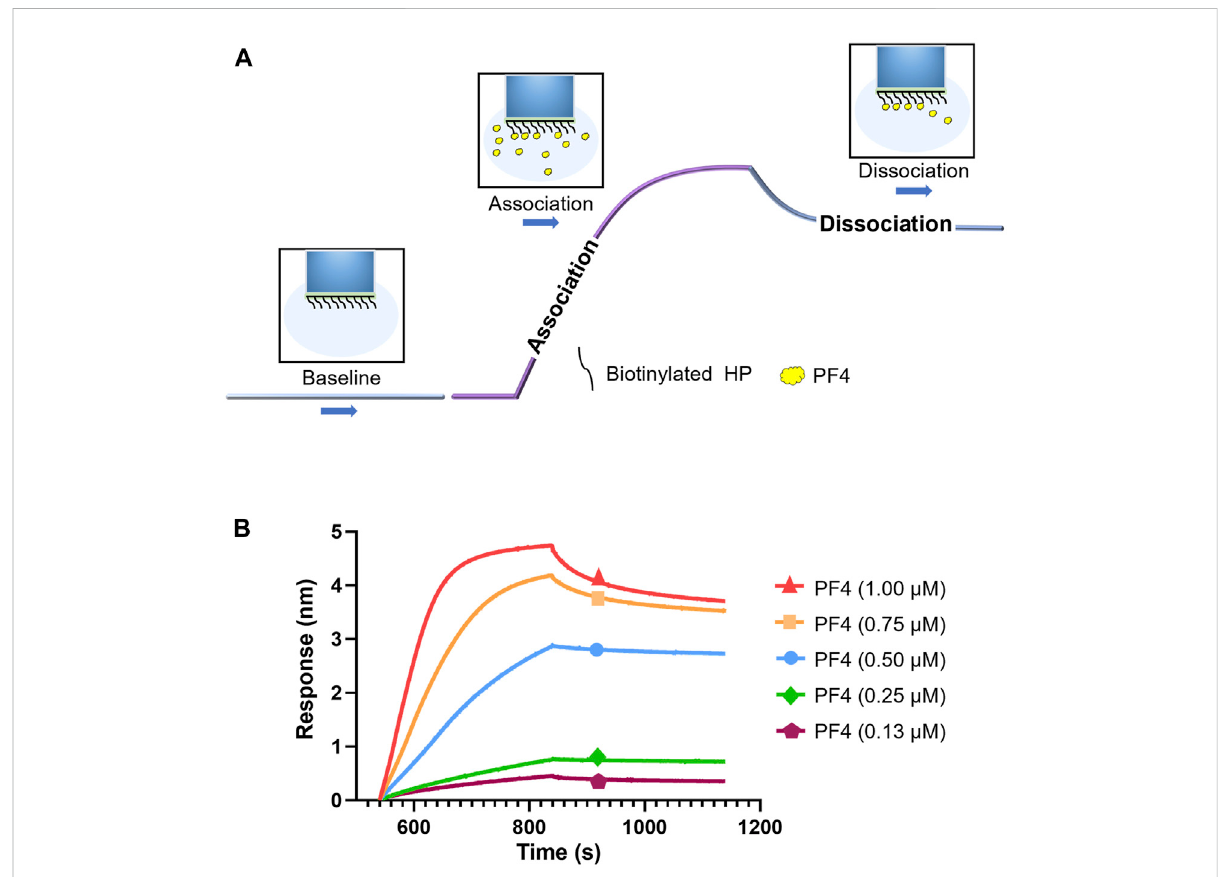
Kinetic measurement of interaction between HP and PF4. (A) Work fl ow of kinetic measurement using BLI. (B) BLI sensorgrams of PF4-HP